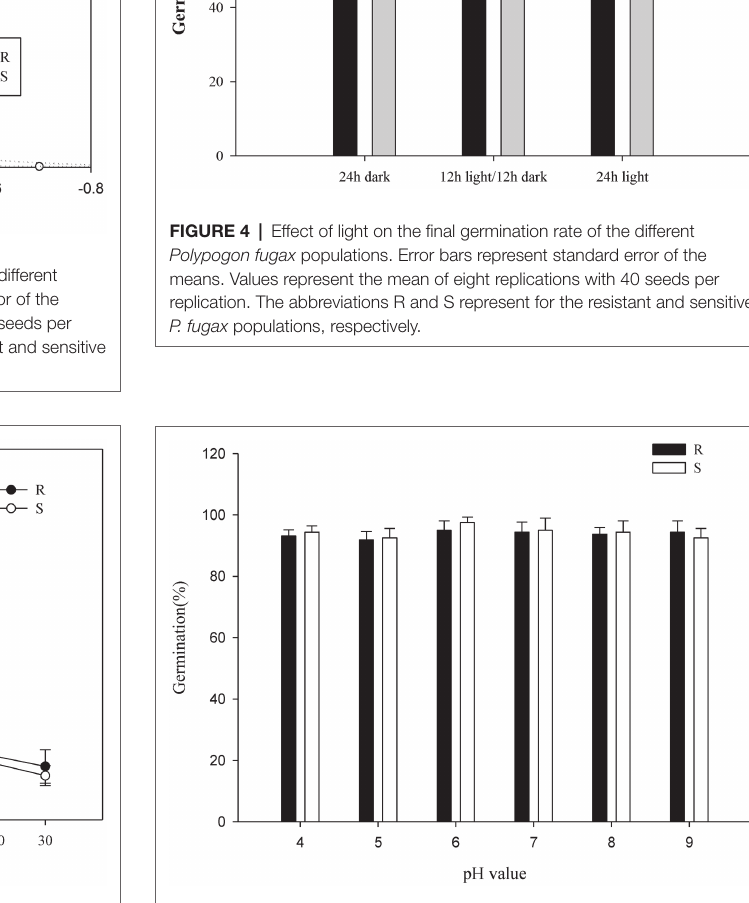
FIGURE 3 | Effect of temperature on the final germination rate of the different Polypogon fugax populations. Error bars represent standard error of the means. Values represent the mean of eight replications with 40 seeds per replication. The abbreviations R and S represent for the resistant and sensitive P. fugax populations,